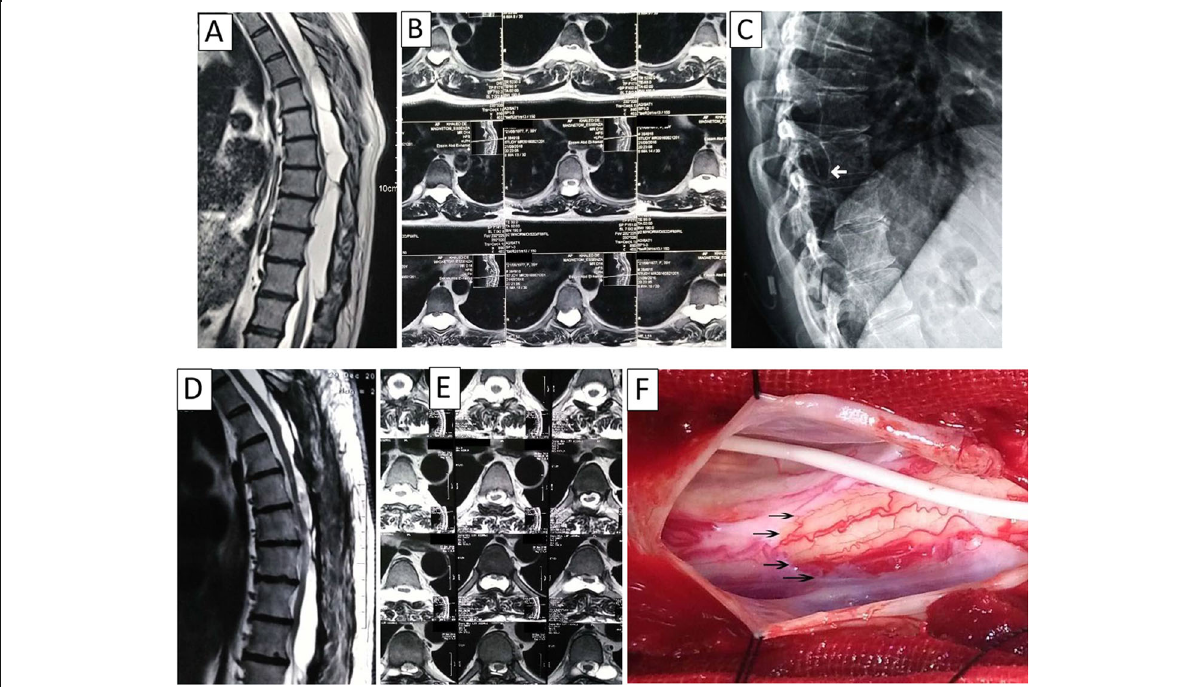
Fig. 2 Case 2: 34-year-old male presented by persistent back pain and moderate restriction of daily activity after history of being operated for cystoperitoneal shunt in another center. Initial MRI pictures before the first surgery were not available, plain X-ray on shunt tube (white arrow, c ) showed both spinal and peritoneal ends in place, sagittal and axial T2 MRI ( a , b ) showing multilocular dorsal thoracic cyst compressing the cord. The patient was operated for microscopic excision of the outer cyst wall, fenestration of the septa, and marsupialization of the inner wall (black arrows, f ), shunt tube was left in place ( f ). The patient improved immediately after surgery and follow up MRI sagittal and axial T2 ( d , e ) showed cord decompression. No cyst recurrence was observed during annual follow-up